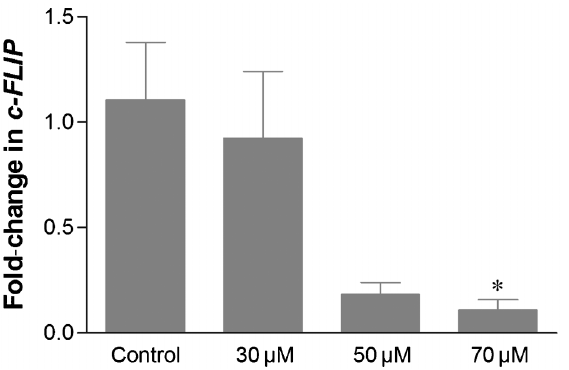
Figure 5. c-FLIP gene expression in U87 cells. The y-axis indicates the fold-change in c-FLIP expression. Data are reported as means ± SD for 3 measurements. The expression of c-FLIP was compared between cells that had been treated with different concentrations of kaurenoic acid (KA) for 48 h and untreated cells. *P , 0.05 for 70 m M KA treatment vs control cells (Bonferroni multiple comparison test).